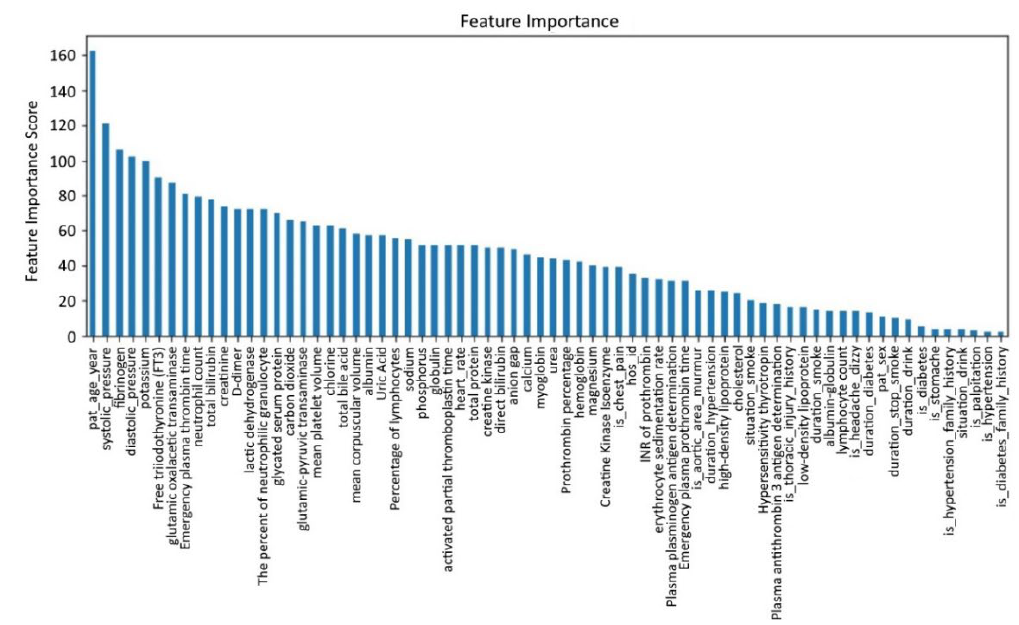
Figure 4. Feature importance analysis.